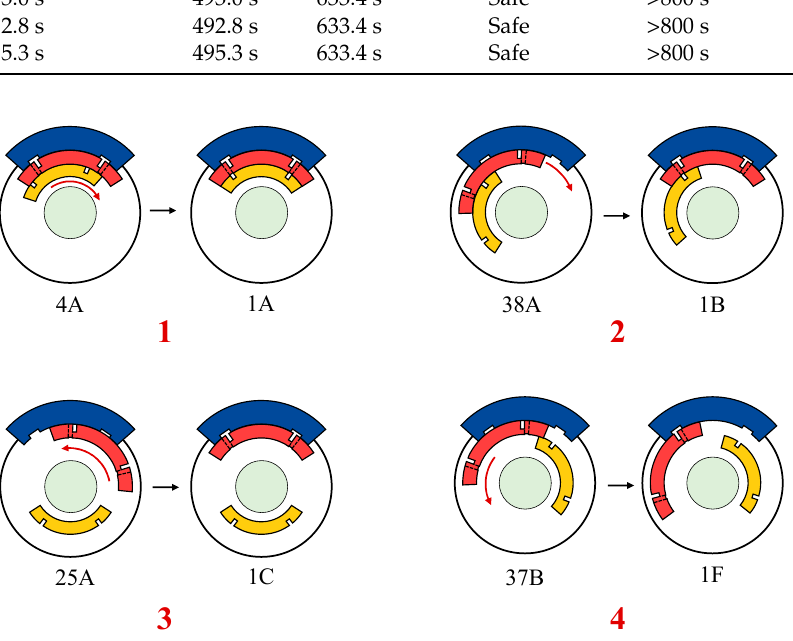
Figure 23. Transformation of Cases 4A, 38A, 25A, 37B into Cases 1A, 1B, 1C, 1F by rotating auditorium B and C.